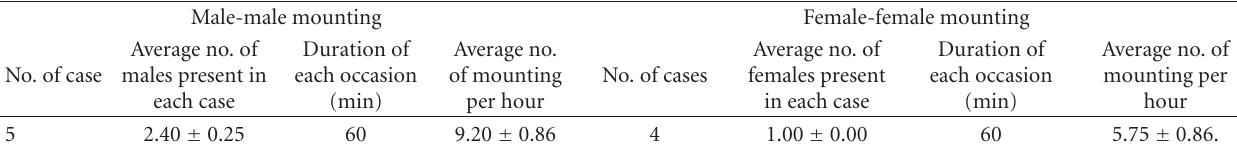
Table 5: Male-male and female-female